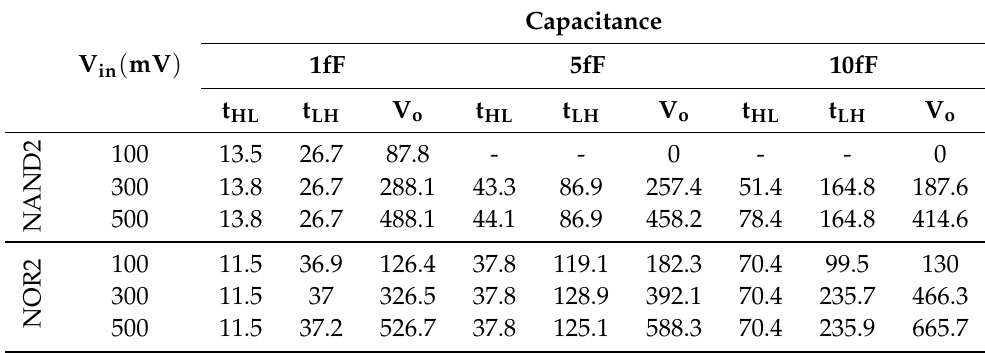
Table 2. Propagation delays and output pulse widths for the 1 → 0 → 1 transition.